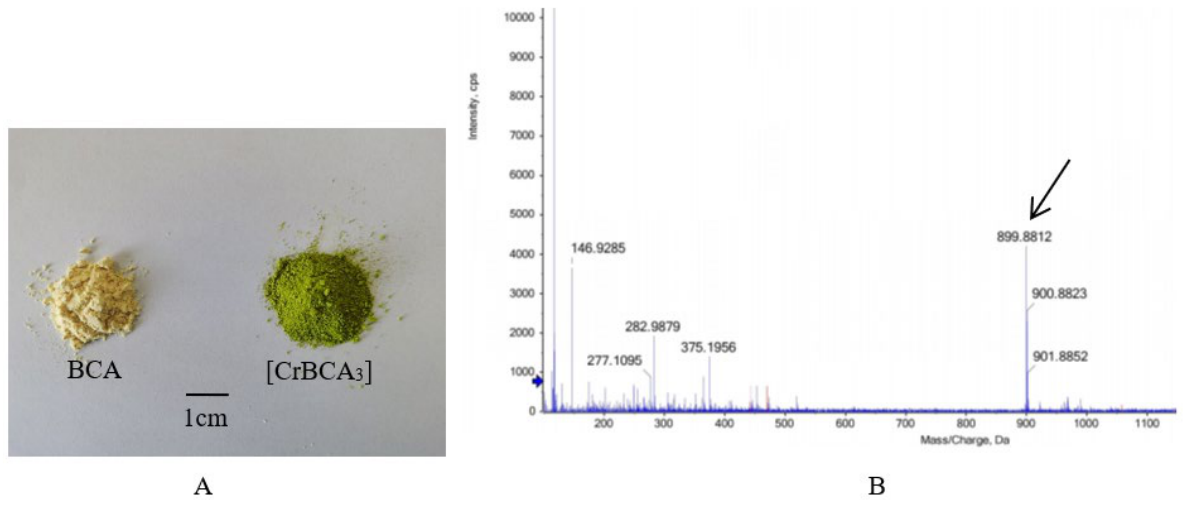
Figure 1. Sample condition and HRMS. ( A ) BCA and [CrBCA 3 ]. ( B ) Mass spectrum of [CrBCA 3 ].